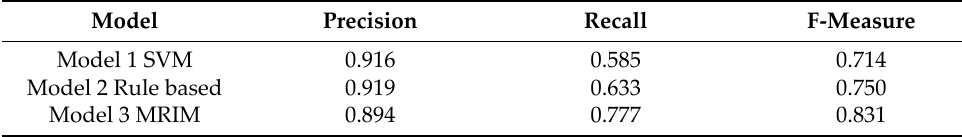
Table 5. Classification performance